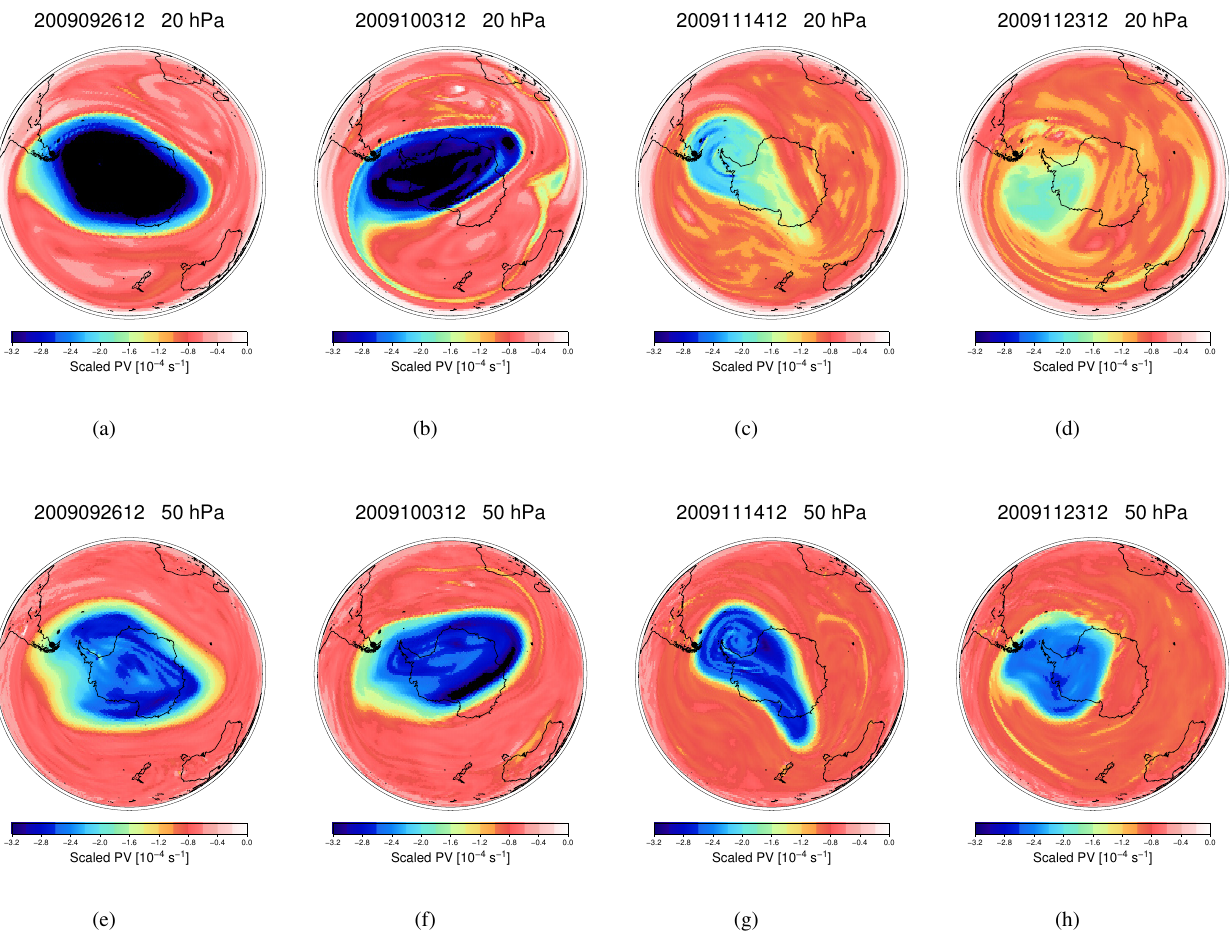
Figure 4. Scaled PV maps from MERRA-2 on 26 September (a, e) , 3 October (b, f) , 14 November (c, g) , and 23 November 2009 (d, h) . Top and bottom rows show pressure surfaces at 20 and 50hPa,